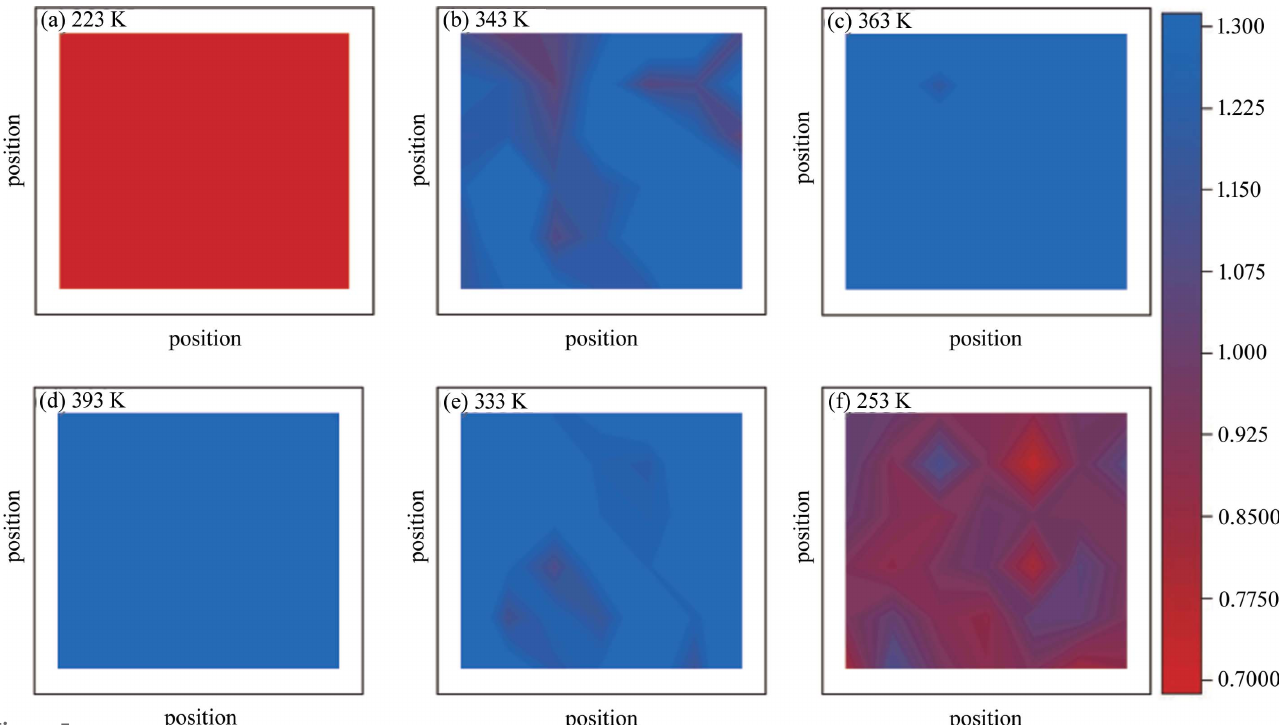
Figure 5 In situ 2D Raman mapping of polycrystalline powders after 90 min of milling ( (cid:3) ! (cid:2) ! (cid:3) ). The horizontal and vertical coordinates represent the position of the micro-region characterized by Raman spectra, and the scale is the ratio of the peak intensity between 782 and 762 cm (cid:4) 1 . Red and blue represent the pure (cid:3) and (cid:2) forms,